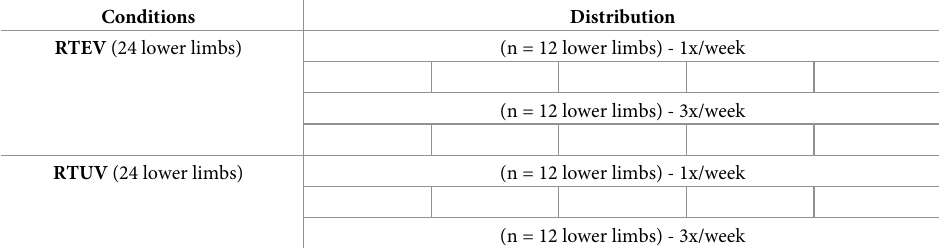
Table 1. Distribution of subjects’ lower limbs among conditions. Conditions Distribution RTEV (24 lower limbs) (n = 12 lower limbs) - 1x/week (n = 12 lower limbs) - 3x/week RTUV (24 lower limbs) (n = 12 lower limbs) - 1x/week (n = 12 lower limbs) - 3x/week RTEV, resistance training with equalized total training volume; RTUV, resistance training with unequalized total training volume. Note : In both conditions, the lower limbs were distributed in a balanced way in the different frequencies ( i . e ., right lower limbs 1x/week n = 6; left lower limbs 3x/week n = 6; right lower limbs 3x/week n = 6; left lower limbs 1x/week n =